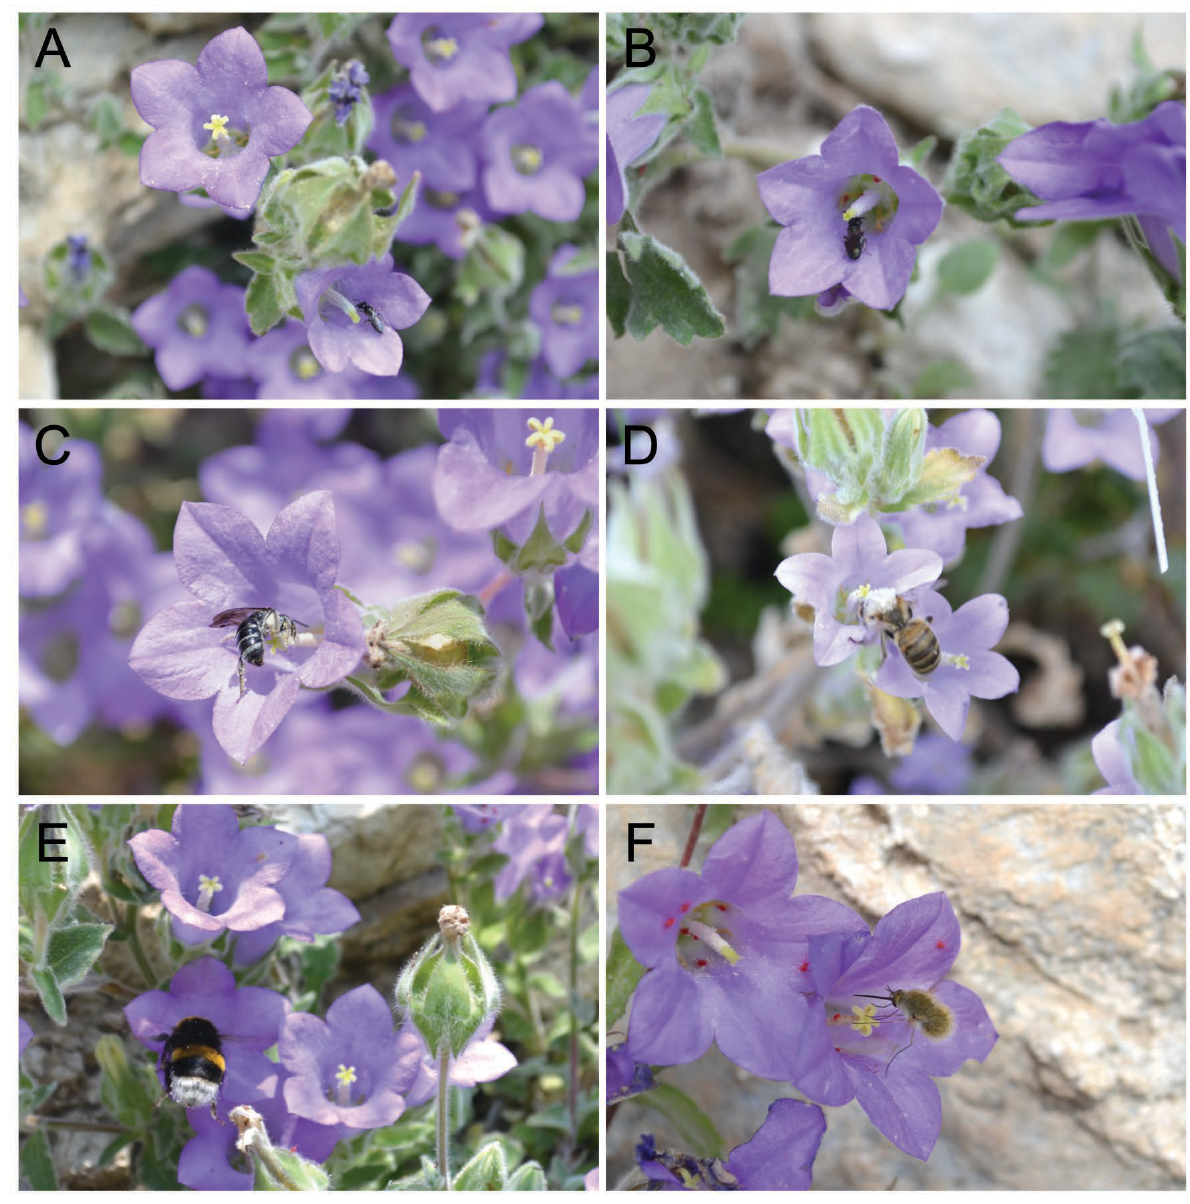
Figure 1 – Pollinators of Campanula vardariana . A . Lasioglossum ( Evylaeus ) morio (Fabricius, 1793). B . Lasioglossum ( Evylaeus ) glabriusculum (Morawitz, 1872). C . Lasioglossum discum (Smith, 1853). D . Apis mellifera Linnaeus, 1758. E . Bombus terrestris (Linnaeus, 1758). F . Bombylius sp. Photographs by Ümit